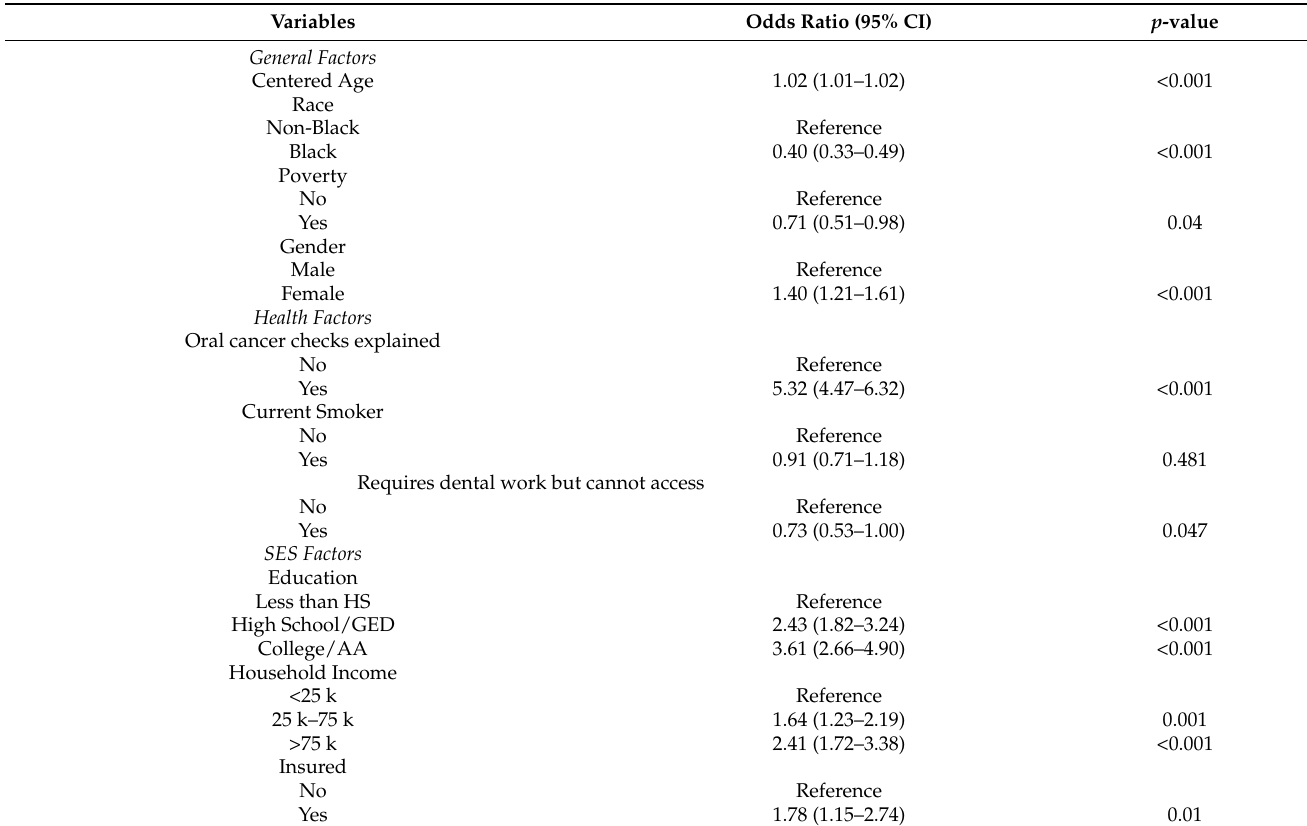
Table 2. Survey weighted multivariate logistic regression with outcome of receiving an oral cancer check, N = 9739. Variables Odds Ratio (95% CI) p -value General Factors Centered Age 1.02 (1.01–1.02) <0.001 Race Non-Black Reference Black 0.40 (0.33–0.49) <0.001 Poverty